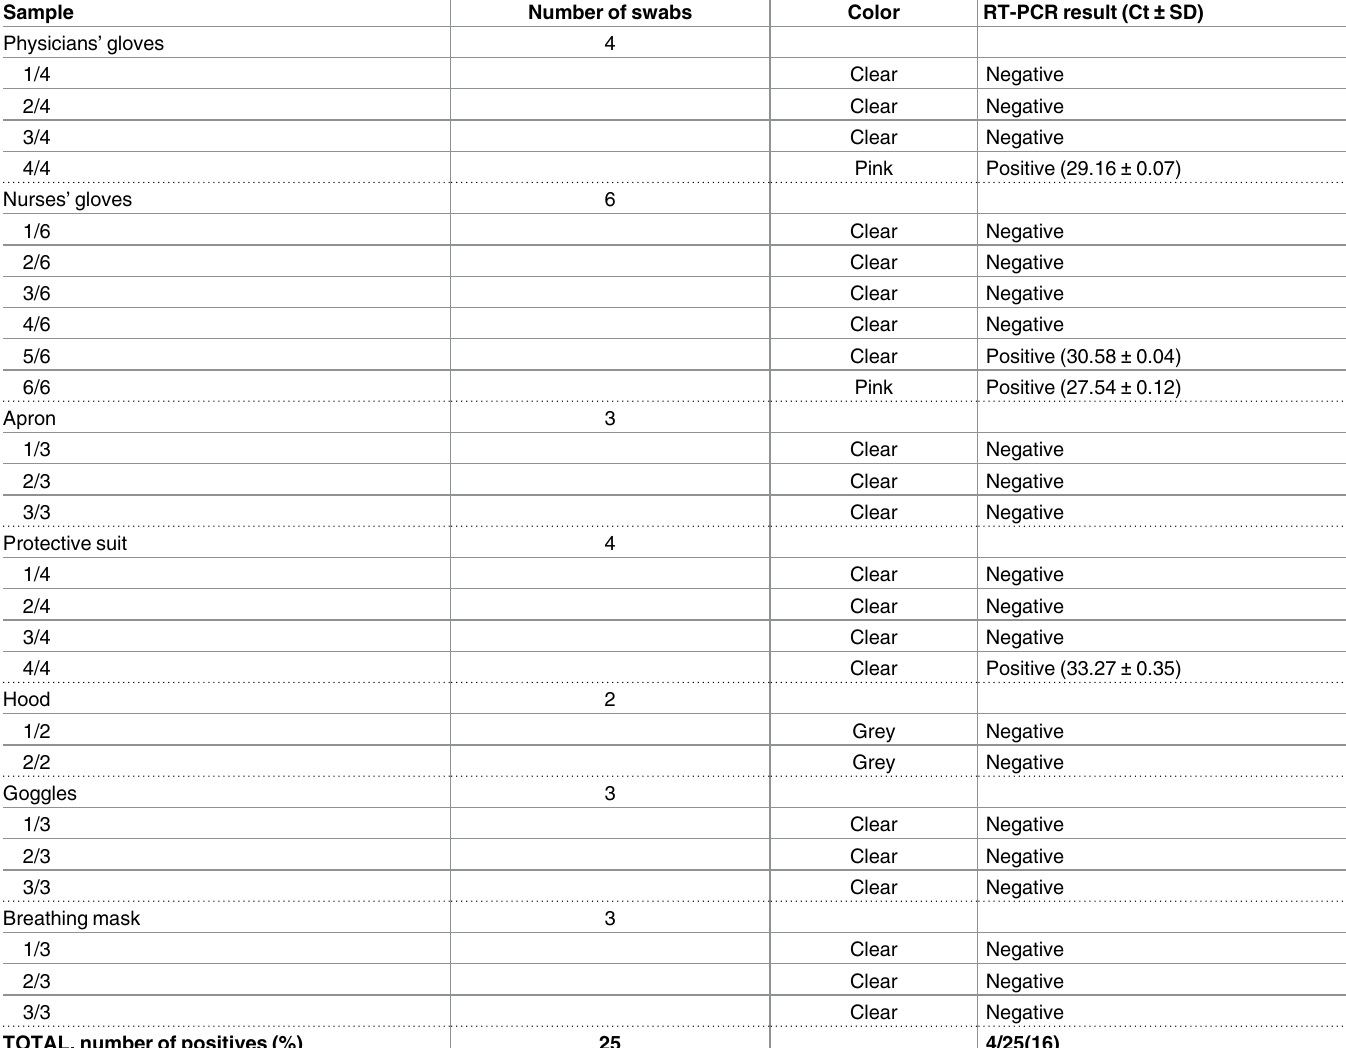
Table 2. Samples from personal protective equipment in high-risk